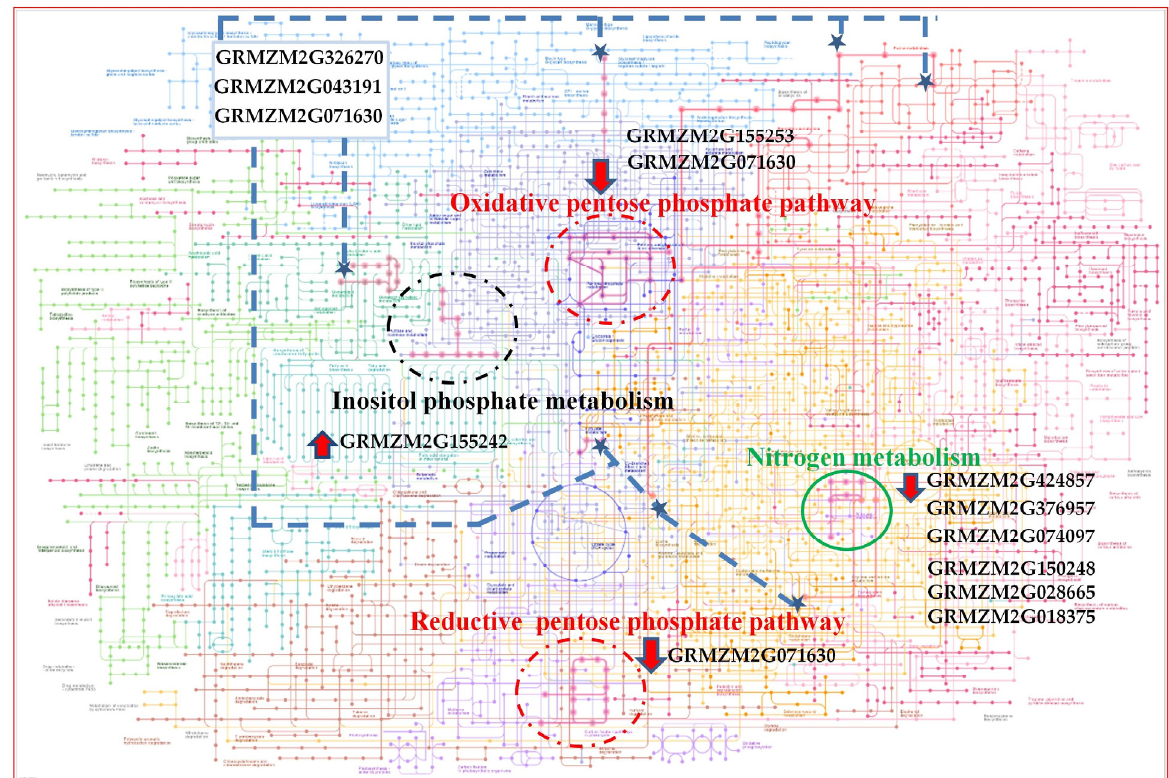
Figure 11. The metabolomics network employed to highlight the transcripts involved in phosphate and nitrogen metabolism in maize under drought stress and recovery. The up- and down-pointing arrows show the upregulated and downregulated DETs, respectively. The stars indicate the possible predicted phosphate metabolic network. The highlighted (circular) pathways are based on the threefold change